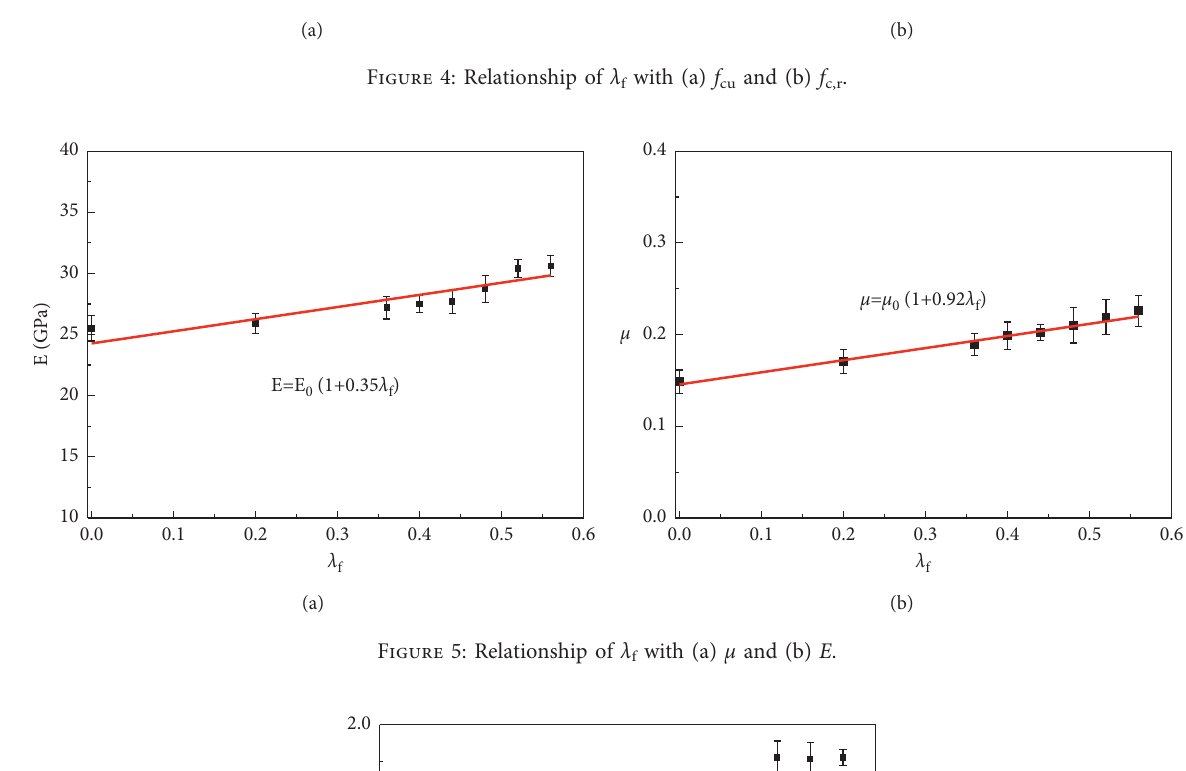
f with (a) μ and (b) E .